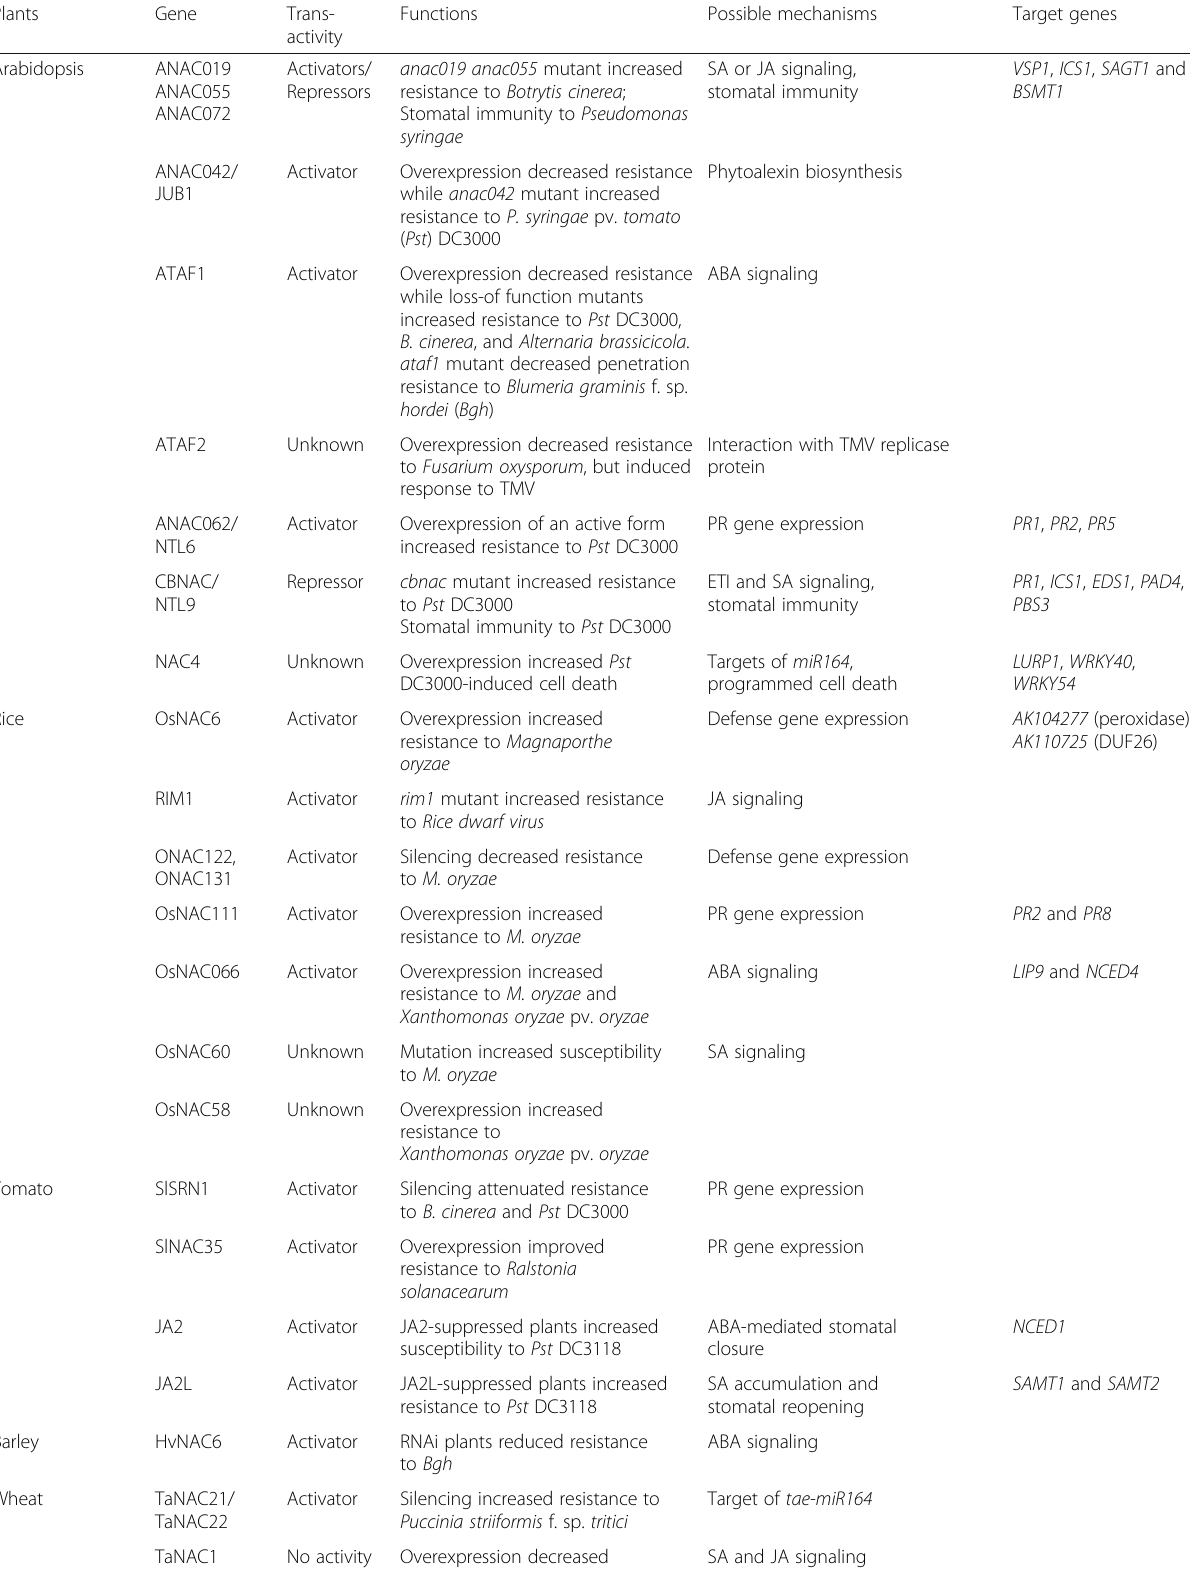
Table 1 Functional and biochemical features of the reported immunity-related NAC transcription factors